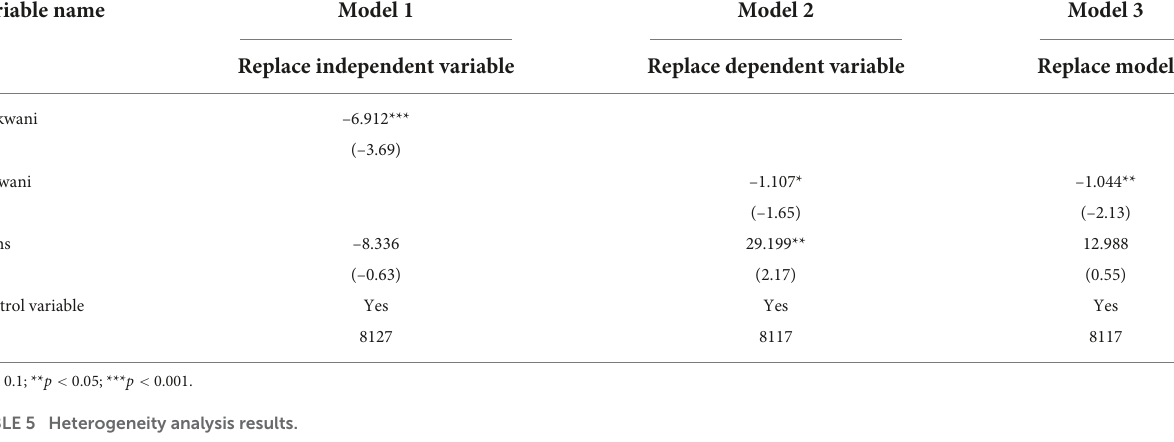
TABLE 4 Robustness check results.